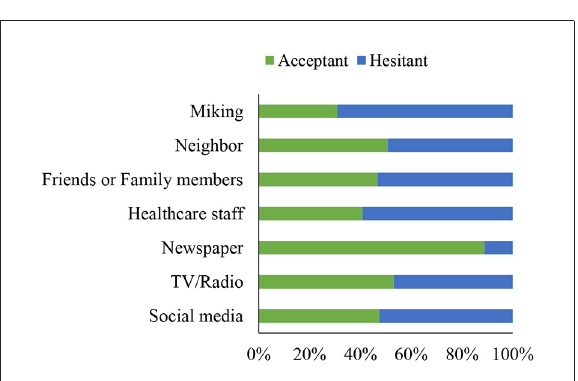
FIGURE3 Information sources among the acceptant and hesitant